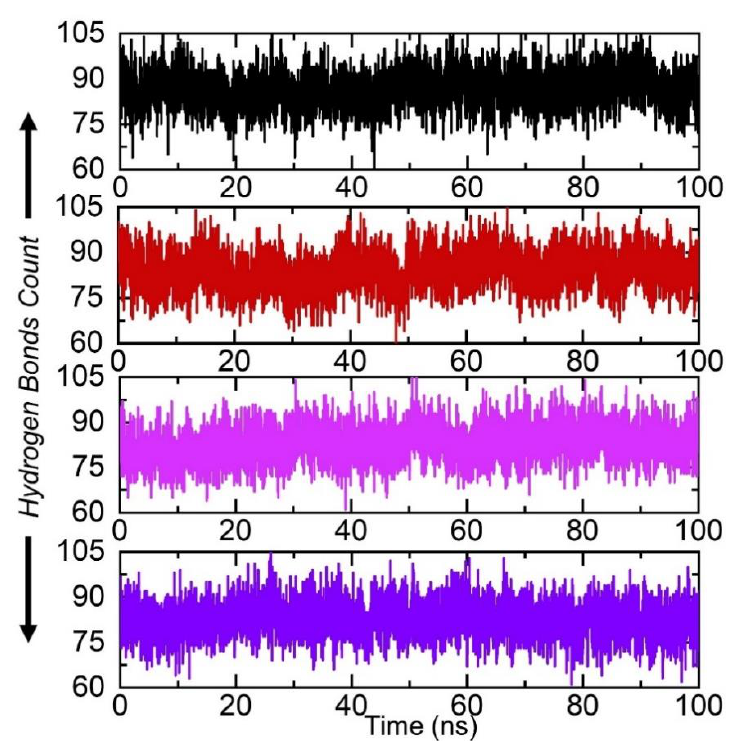
Figure 6. Hydrogen bonding analysis of the wildtype and W68L, L85P, and T87A mutants. The wild type structure is shown as black, W68L (red), L85P (magenta), and T87A (purple).